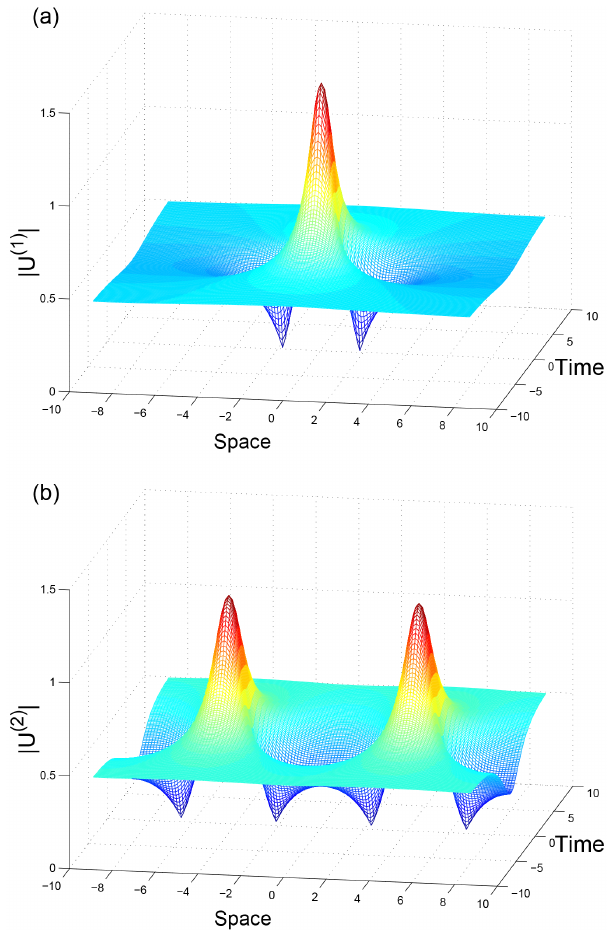
Figure 2. Amplitude plots of the two-mode SPB over a plane wave with two UMs when the modes are (a) distinct and (b)